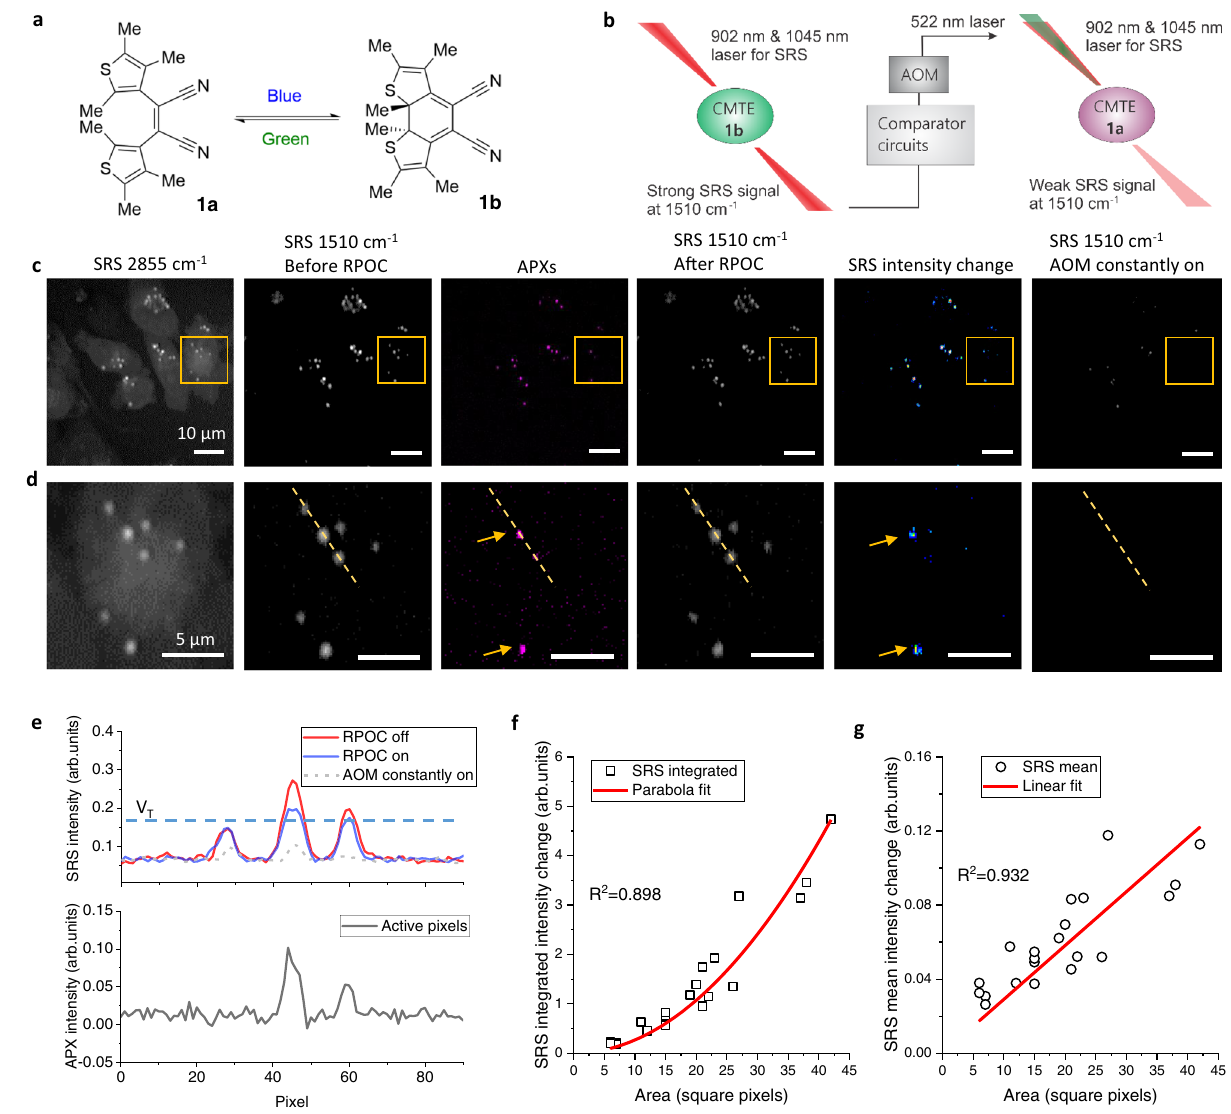
Fig.4|Precisioncontrolandquantitativecomparisonofsite-speci fi cchemical changes using RPOC. a An illustration of switching states of CMTE between the open cis isomer ( 1a ) and the closed isomer ( 1b ) forms using blue and green light. b An illustration of the work fl ow for CMTE conversion by the RPOC using the 1510cm − 1 SRS signal and a 522nm laser. AOM: acousto-optic modulator. c An sti- mulated Ramanscattering (SRS)image at 2855cm − 1 , at1510cm − 1 beforeRPOC,the active pixels (APXs), at 1510cm − 1 after RPOC using V T =0.17V, the SRS intensity difference before and after RPOC, at 1510cm − 1 after the AOM constantly on for 20